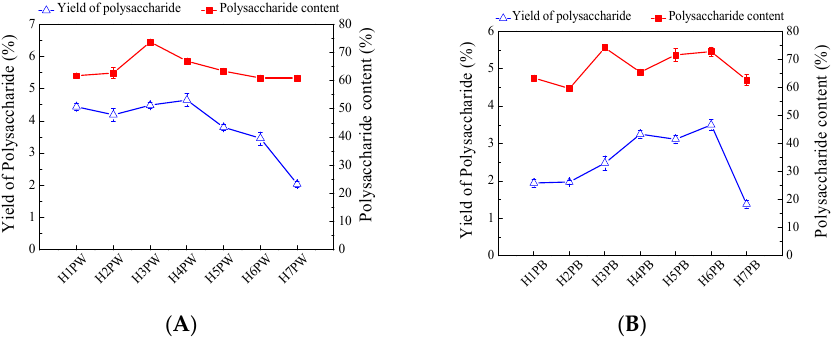
Figure 3. Yields and content of ( A ) water-soluble and ( B ) alkaline-soluble cell wall polysaccharides from Hericium erinaceus fruiting bodies at different growth stages.